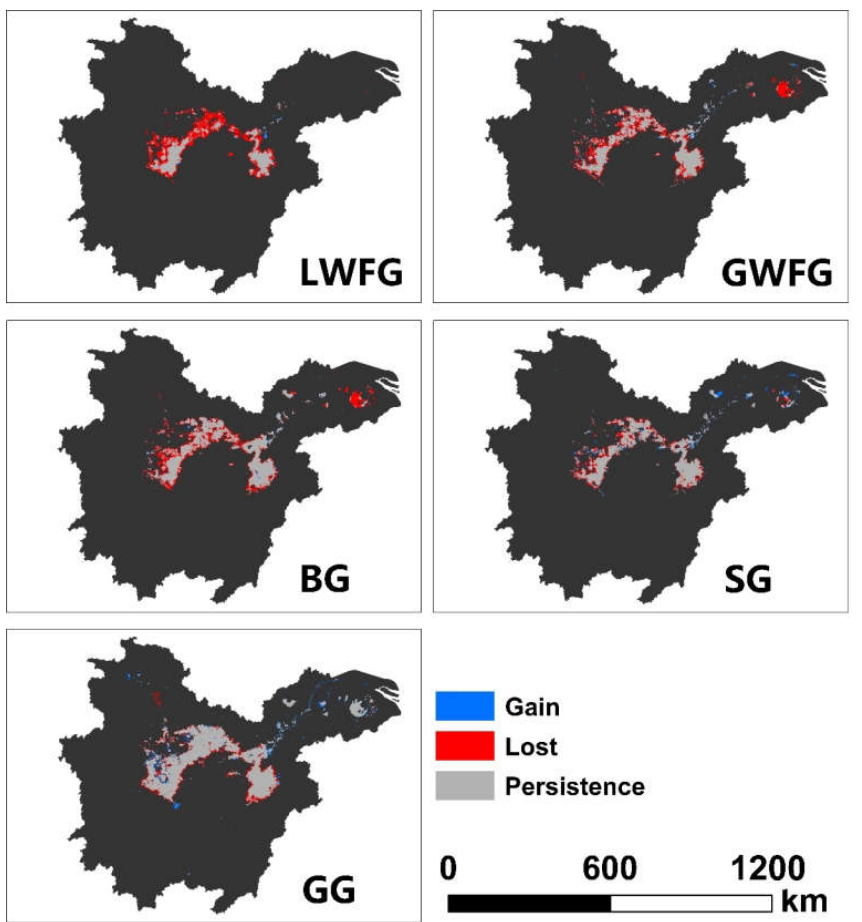
Figure 7. Change in suitable goose habitat during Period 1 and Period 4. Lesser white-fronted goose (LWFG); greater white-fronted goose (GWFG); bean goose (BG); swan goose (SG); and greylag goose (GG).